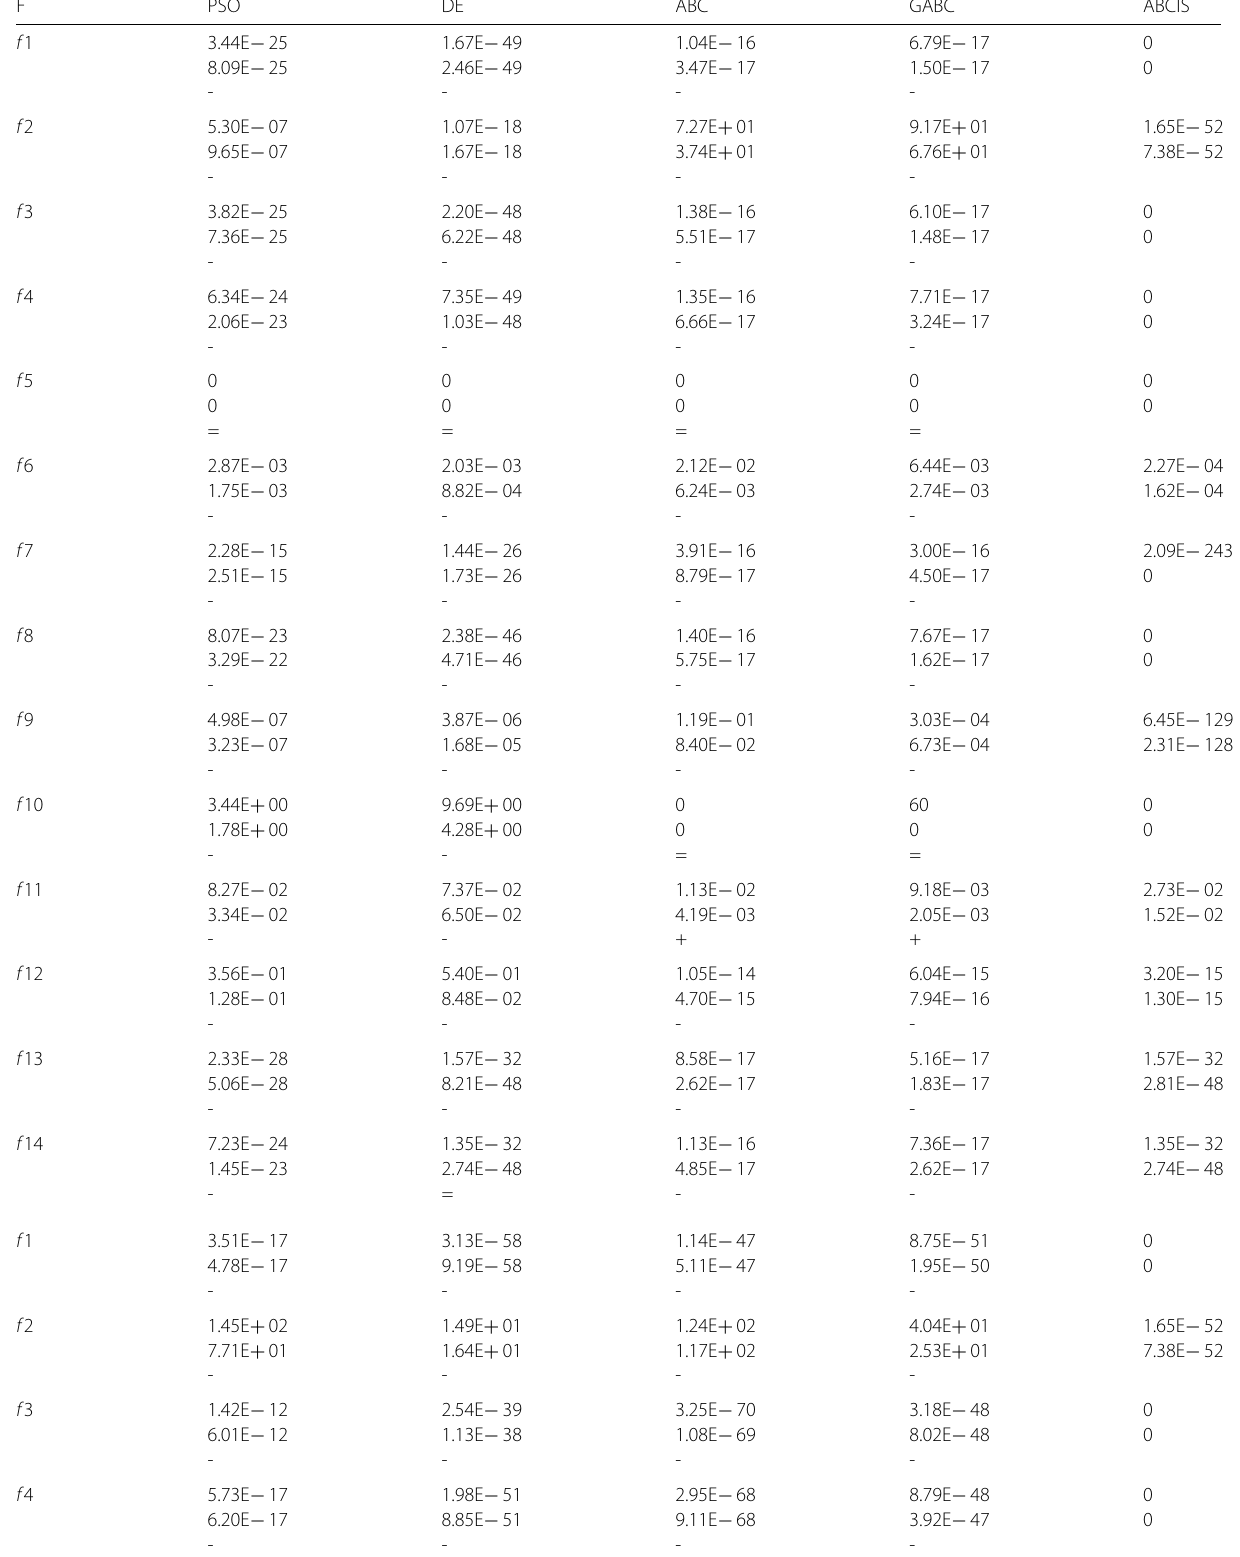
Table 2 Comparison results, D =